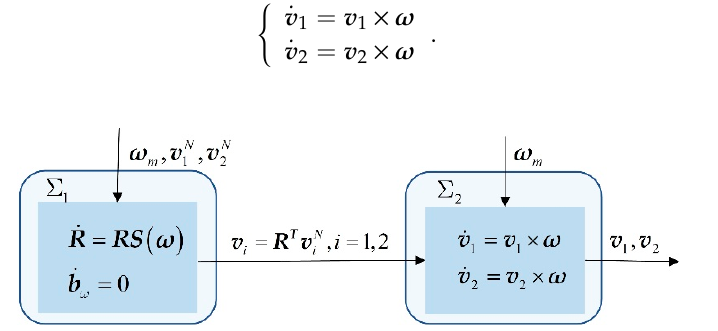
(cid:80) interconnected system. Figure 2. Structure of the nonlinear 2 interconnected 2